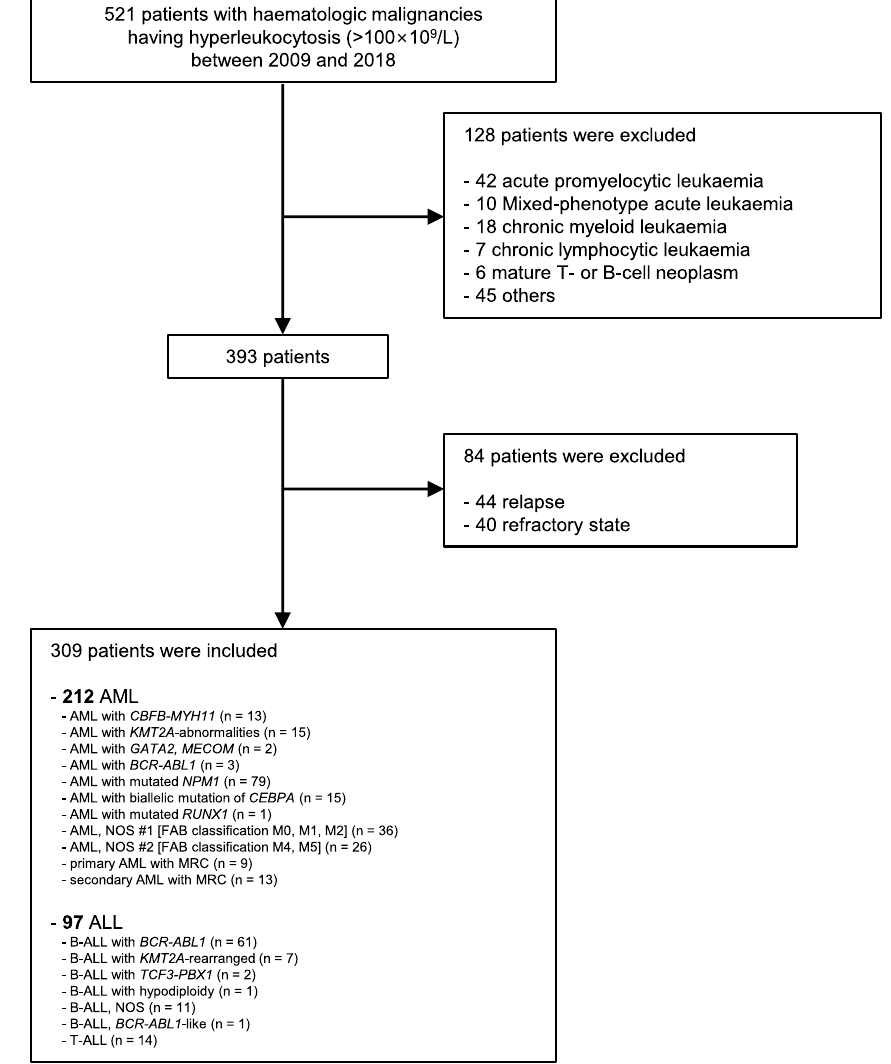
Figure 1. Flow chart. AML acute myeloid leukaemia, ALL acute lymphoblastic leukaemia, FAB French– American–British, MRC myelodysplasia-related